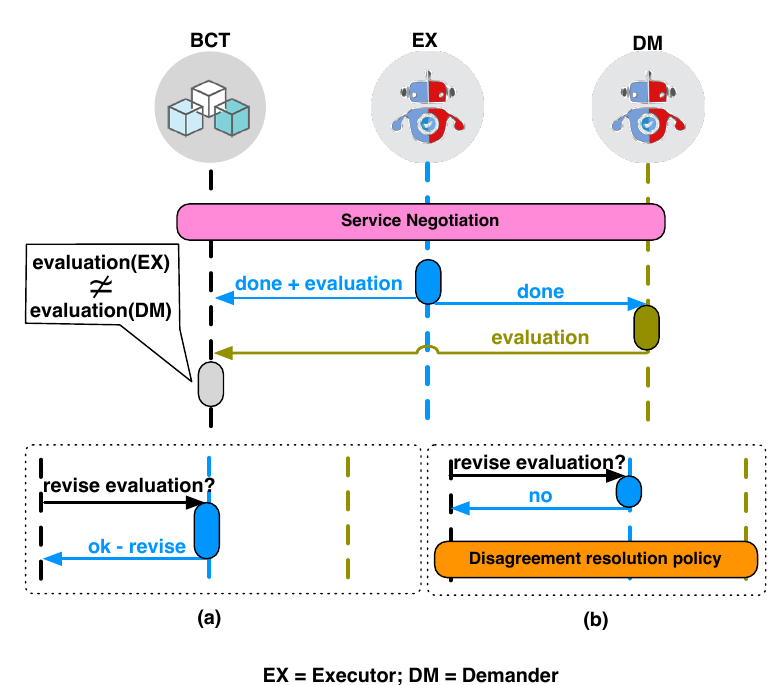
Figure 9. Evaluation management via BCT [9]. ( a ) computed and the ledger updated, ( b ) disagreement resolution process is